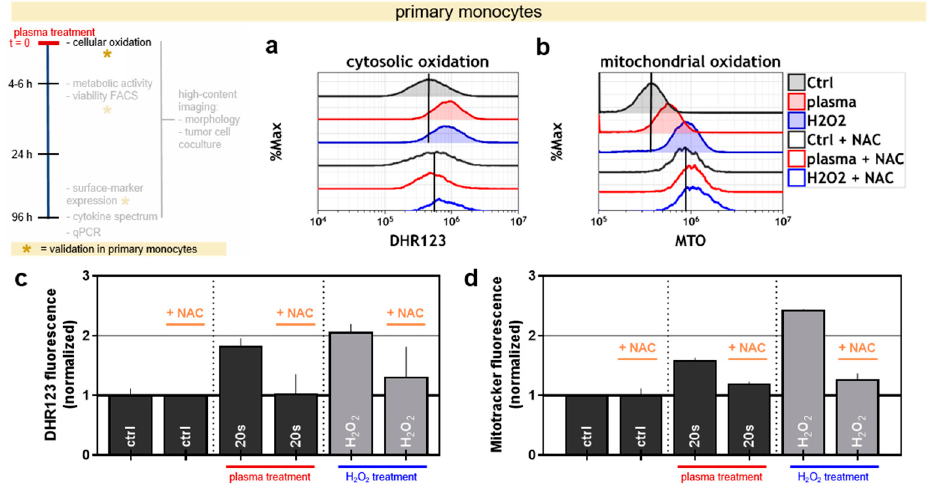
Figure 2. The validation of the oxidizing e ff ect of plasma and H 2 O 2 in primary monocytes. ( a , b ) The representative overlay histograms of monocytes stained with DHR-123 or MTO, which were treated with 20 s plasma or 70 µ M hydrogen peroxide (H 2 O 2 ) in the presence or absence of the antioxidant N-acetyl cysteine (NAC). The geometric mean of the histograms of untreated cells is indicated as black line. ( c ) Normalization of mean fluorescence intensity of DHR-123 and ( d ) Mitotracker Orange (MTO) stained cells. The data ( c , d ) are representatives out of two independent experiments and show the mean and SD. The seconds (s) indicate plasma treatment time, ctrl = control.